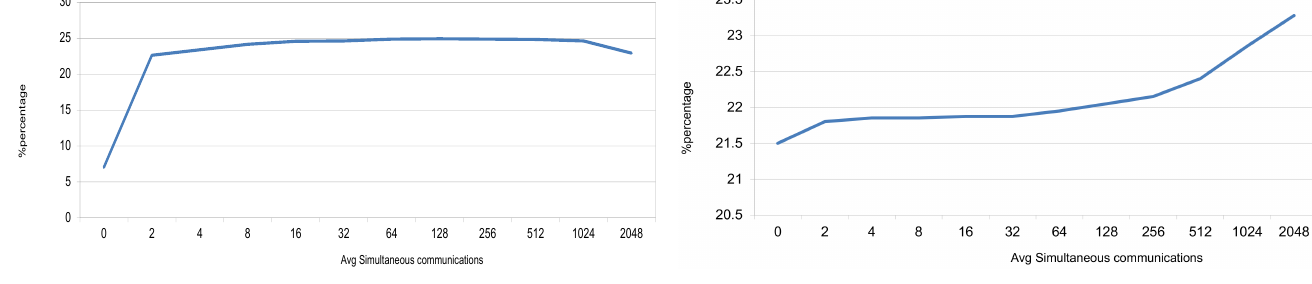
Figure 14. Identity Management Resources